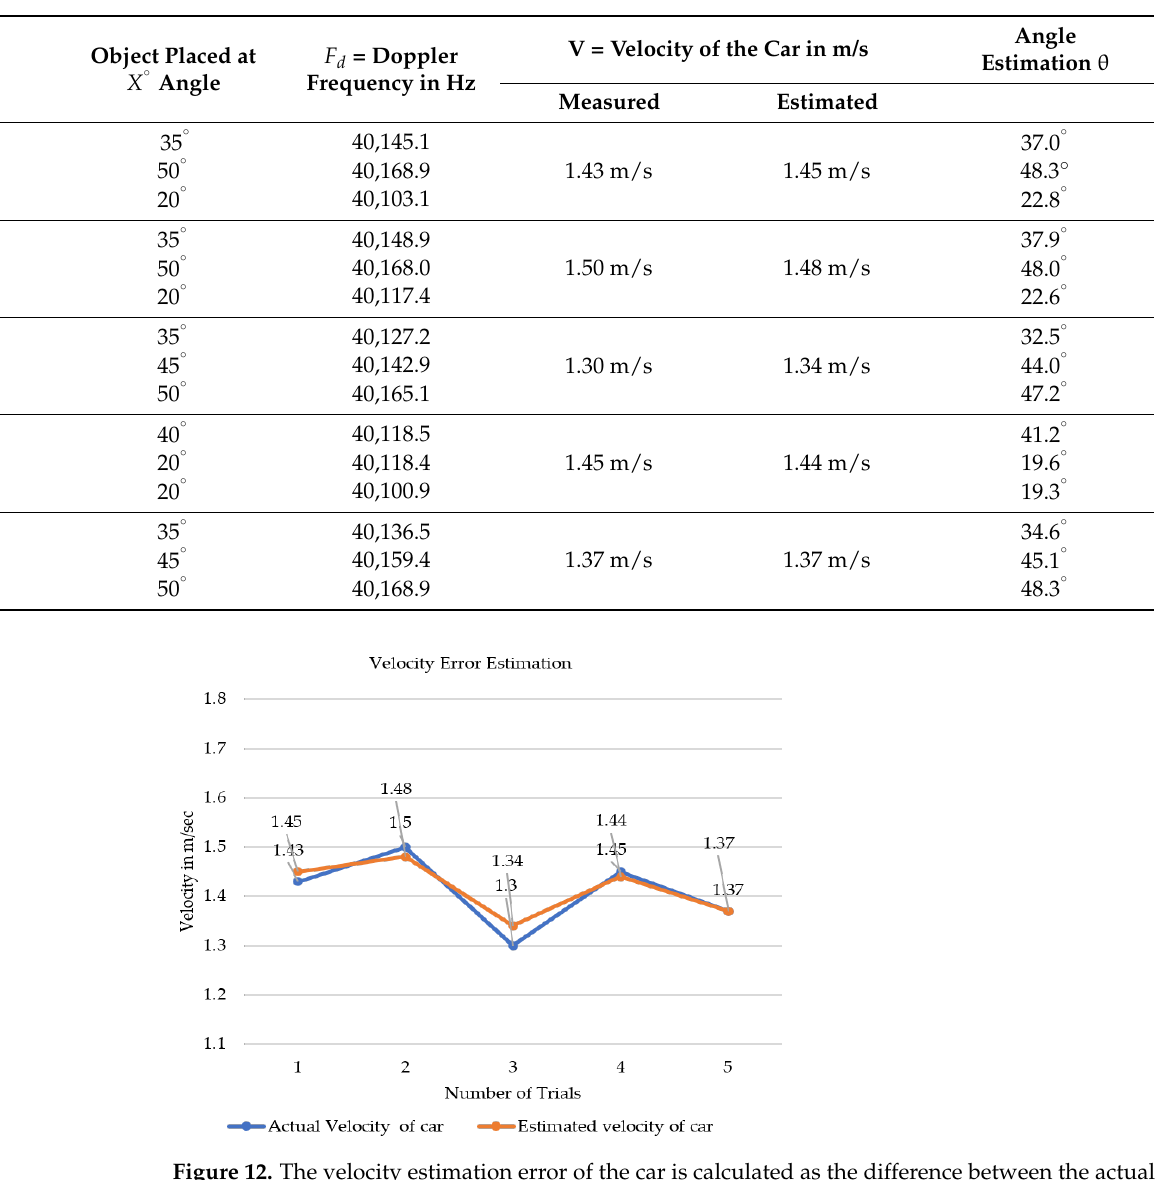
Figure 12. The velocity estimation error of the car is calculated as the difference between the actual and estimated values for different trials. Table 5. Error estimation of the proposed